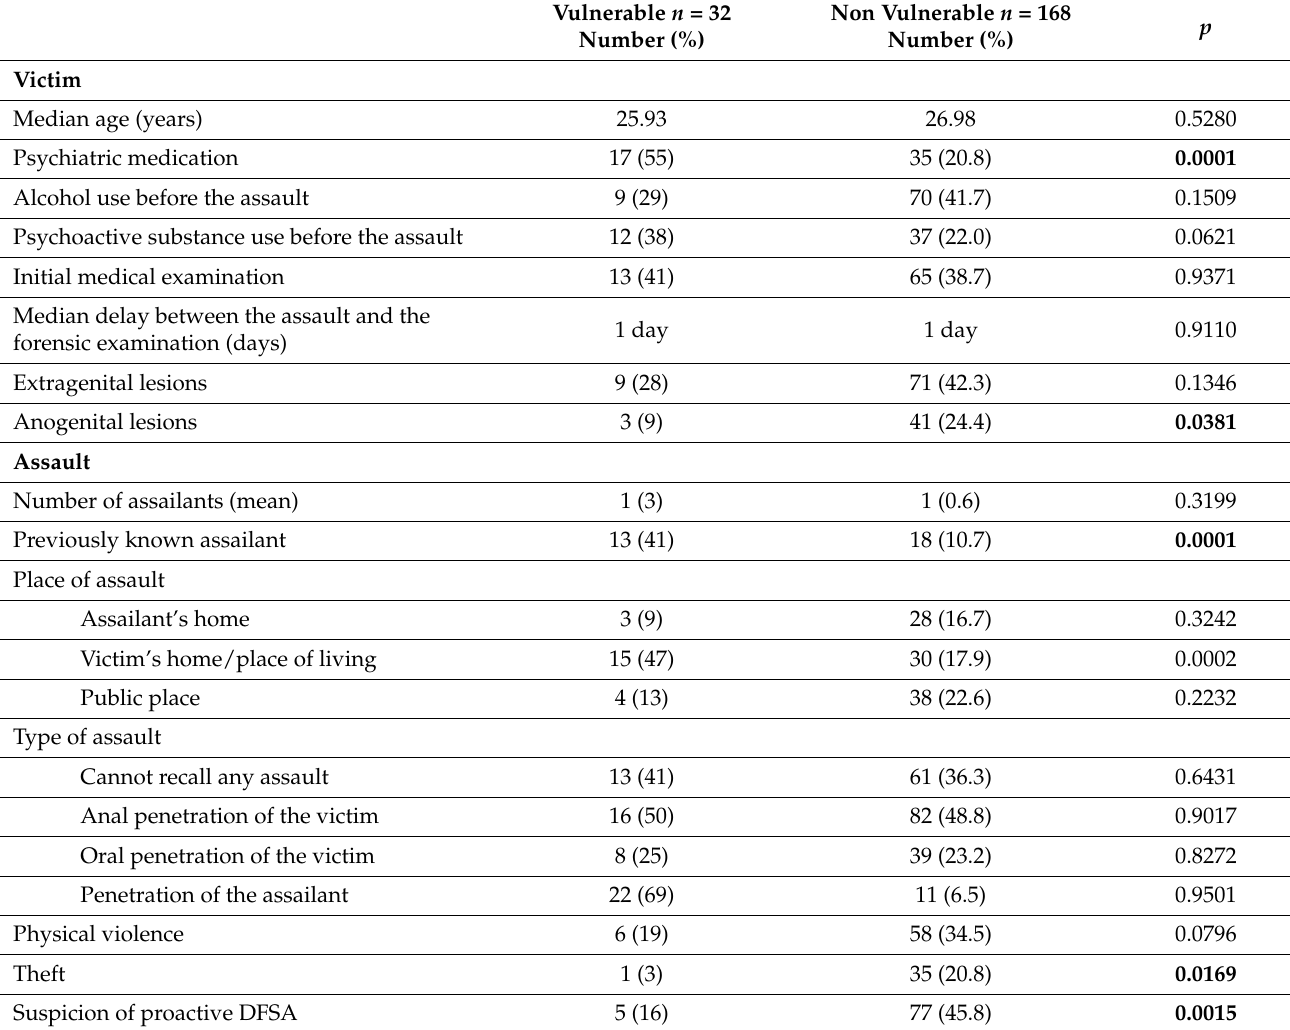
Table 2. Characteristics of the victim and the assault according to the victim’s vulnerability. The bold number were for all p < 0.005